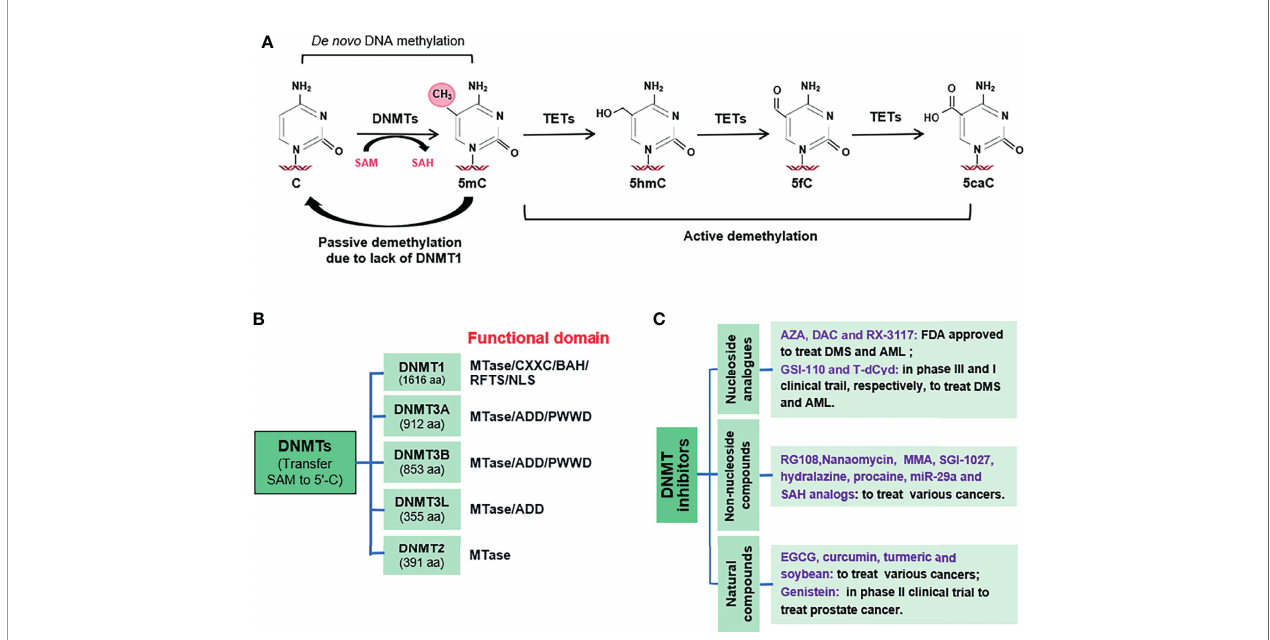
FIGURE 1 | Types of DNA methyltransferases (DNMTs) and antitumor activity of its inhibitors: (A) . Schematic of DNA methyltransferases (DNMTs) transferring methyl donor S-adenosyl-L-methionine (SAM) to cytosine (5 ‘ C) 5 ’ - residues in DNA or removing SAM from DNA. (B) . Functional domains of DNMTs. (DNMT1, DNMT2, DNMT3A, DNMT3B and DNMT3L) (C) . Three types of DNMTs